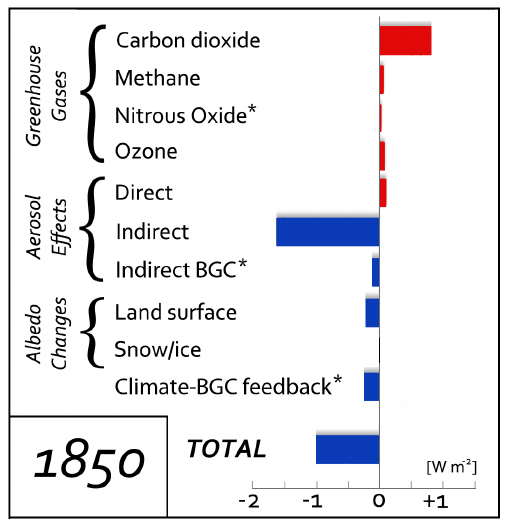
Fig. 11. Global, annual average RF for the various impacts of fires examined in this study, plotted for pre-industrial fires relative to the no-fire scenario. Asterisks indicate RFs that were computed using emissions data and not the CAM model integrations, or the CLM3 no-fire simulations.